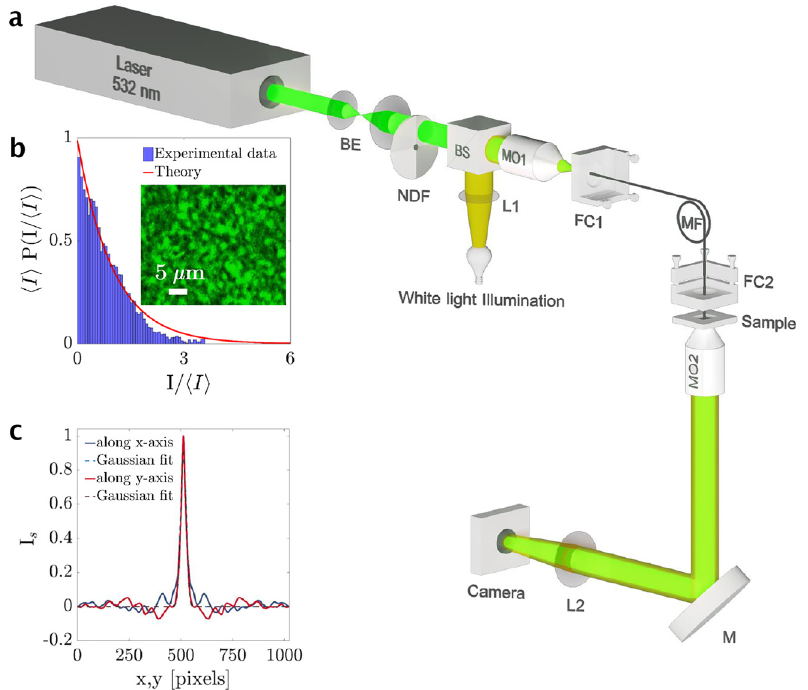
Figure 1: (a) Schematic of the experimental setup; BE: beam expander, MO: microscope objective, MF: multi-mode fiber, NDF: neu- tral density filter, BS: beam splitter, FC: fiber coupler, L: lens, M: mirror. (b) Intensity dis- tributionofthespeckle pattern atthesample plane and negative exponential function fit- ting.Bluebarsdemonstratetheexperimental data and red solid line shows the theoretical probability density function, which follows the negative exponential distribution. Inset: (c) Normalized speckle pattern intensity spa- tial auto-correlation function I as a function s ofposition.Theblueandredlinesarespeckle intensityalong x and y axis,respectively,and the dashed blue and red lines are their cor- responding Gaussian functions. The average speckle grain size is determined from